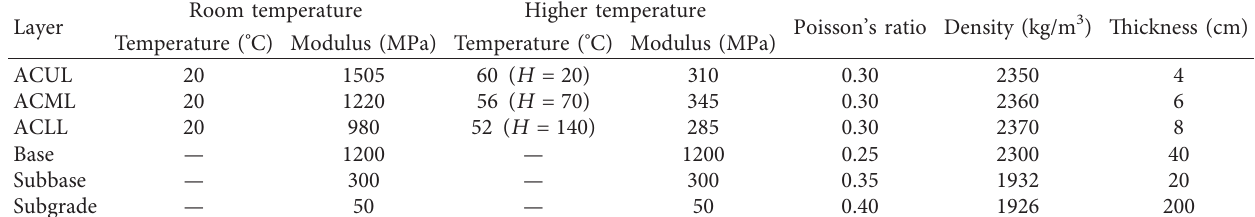
Table 1: Material parameters of semi-rigid base asphalt pavement.